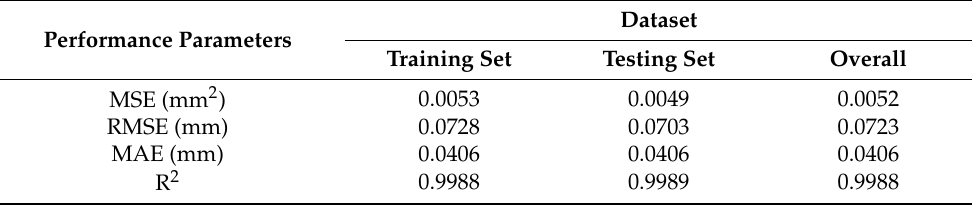
Table 8. The results of prediction accuracy indices of the optimal ANN-based model. Performance Parameters